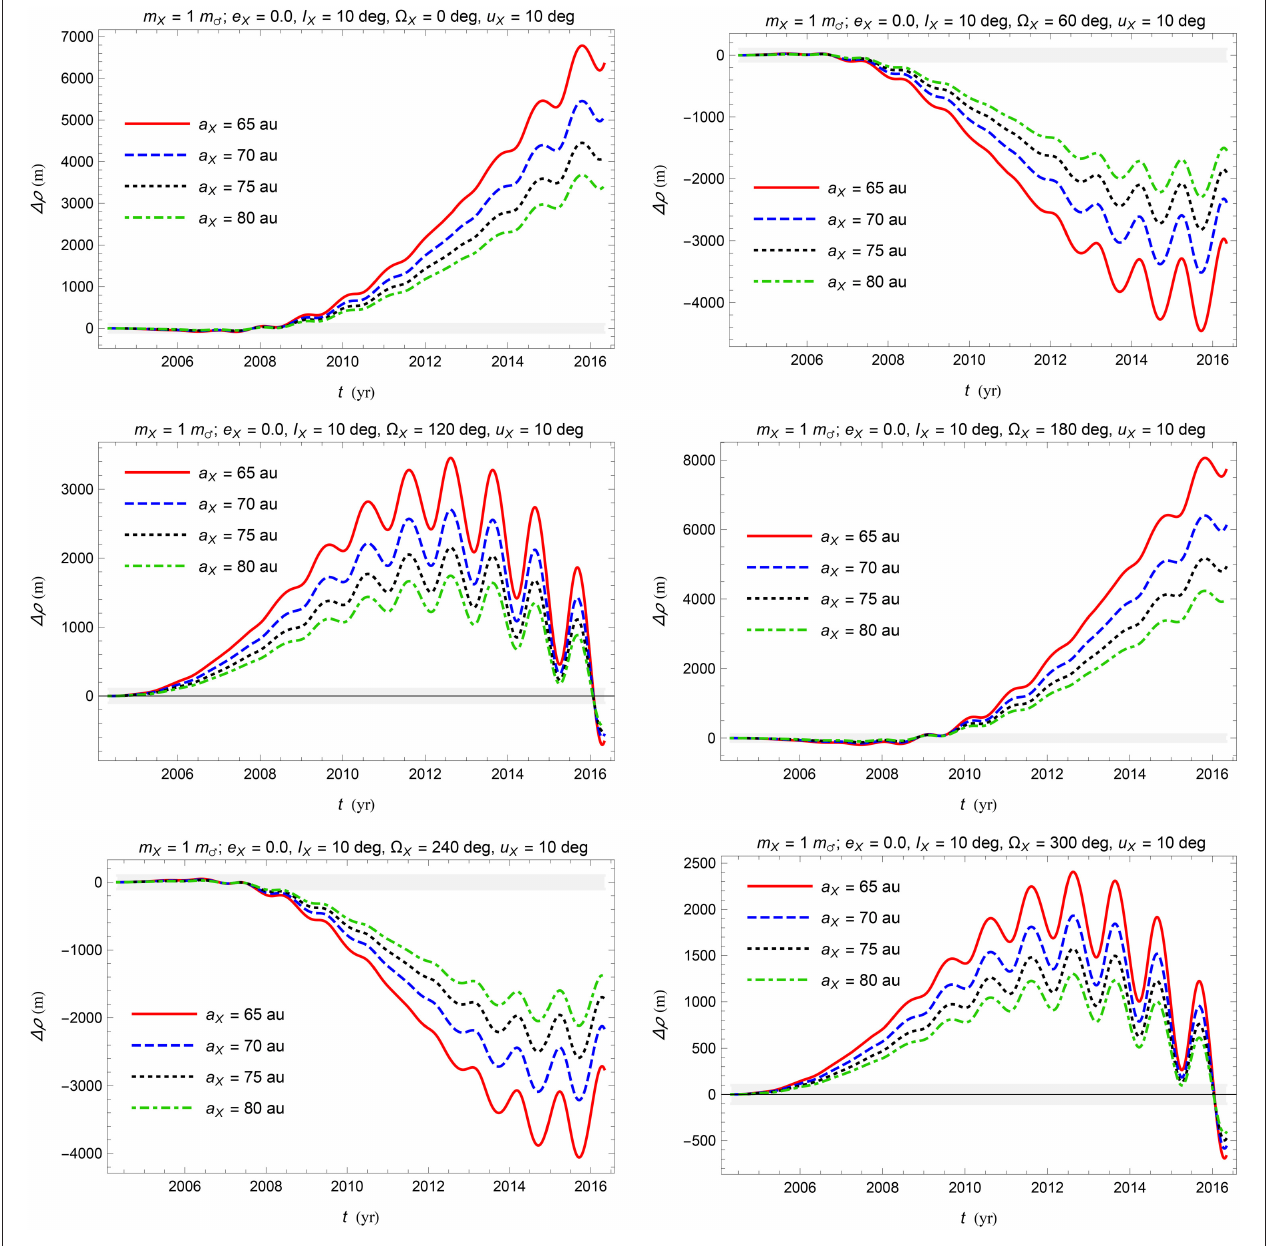
FIGURE 1 | Numerically simulated nominal Kronian range perturbation 1ρ ( t ) , in m, induced by a Mars-sized perturber PX (cid:0) m X = 1 m ♂ (cid:1) (Volk and Malhotra, 2017) over a time span 1 t = 12 year long for different values of its semimajor axis a X and longitude of the ascending node (cid:127) X . PX is assumed to be located close to the ecliptic near the ascending node ( I X = 10 ◦ , u X = 10 ◦ ) along a mildly inclined, circular orbit ( e X = 0 ) . The gray shaded horizontal band in each picture has a semi-amplitude of 100 m , and represents the “standard” post-fit range residuals of Saturn produced by processing the Cassini data without explicitly modeling the dynamics of any PX; cfr. with Figure 1 of Folkner et al.